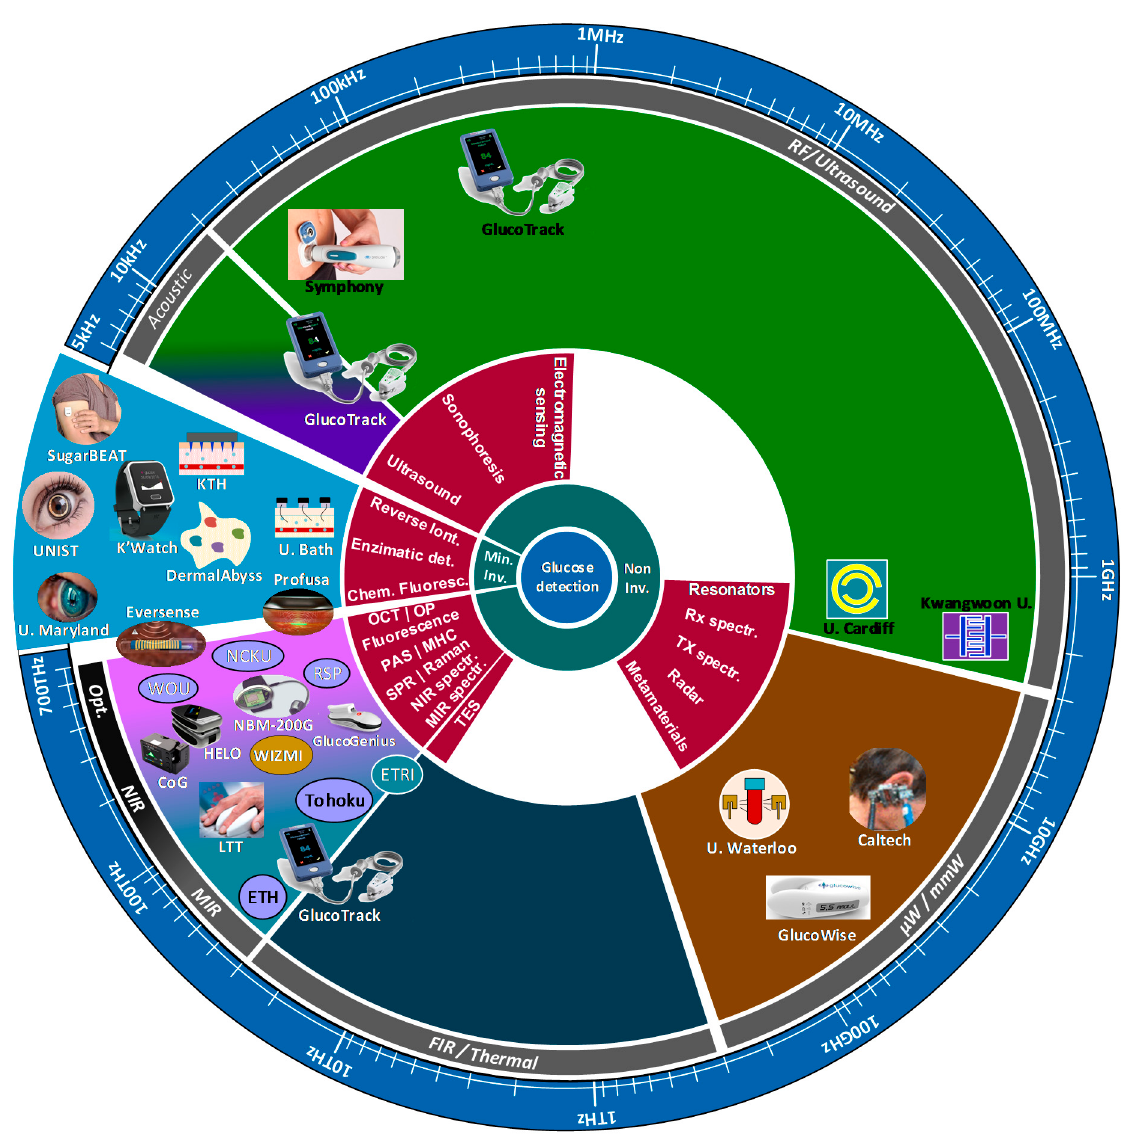
Figure 16. Chart of the current minimally-invasive and non-invasive technologies and devices for glucose and their location in the frequency spectrum.